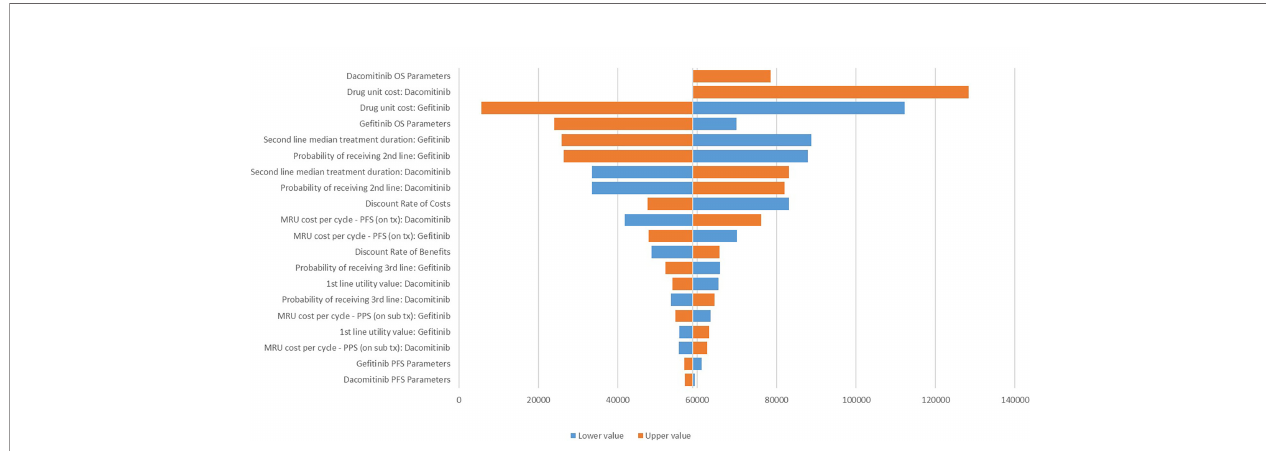
FIGURE 2 | Tornado diagram for the one-way sensitivity analysis. MRU, medical resource use; tx, treatment; OS, overall survival; PFS, progression-free survival; PPS, post-progression survival. The lower values were not tested for the dacomitinib OS parameters and its unit cost due to the negative ICER generated.